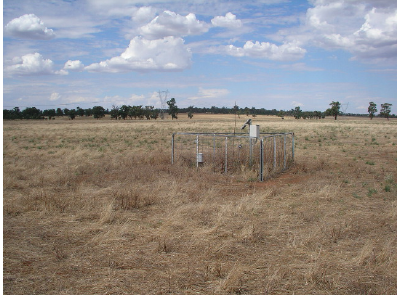
Figure 5. Photo of the Y8 sensor, SMAP Yanco validation